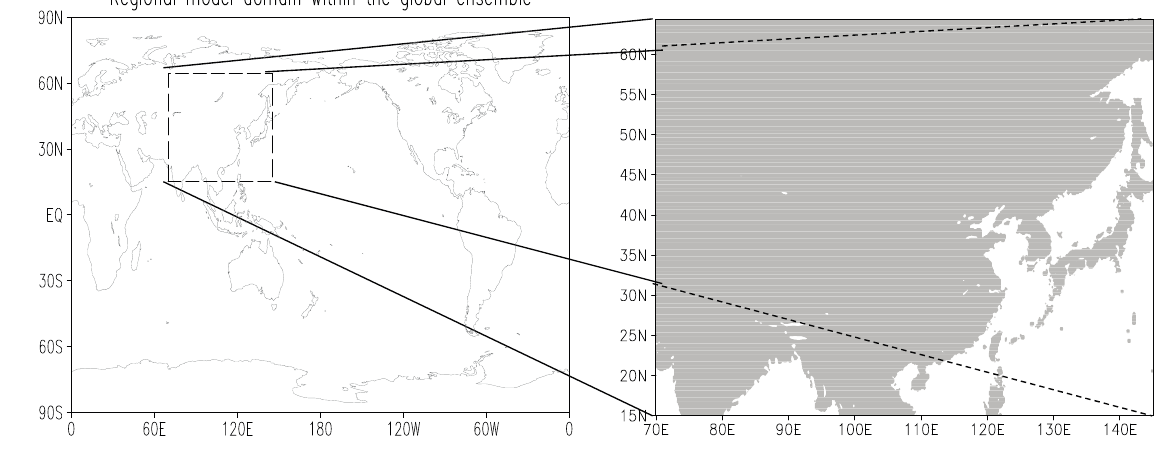
Figure 1. Model domain of GRAPES-REPS within a global